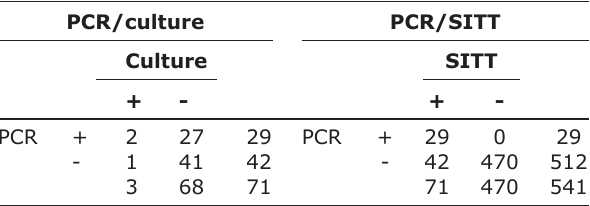
Table-3: Comparison of PCR with culture and SITT. PCR/culture